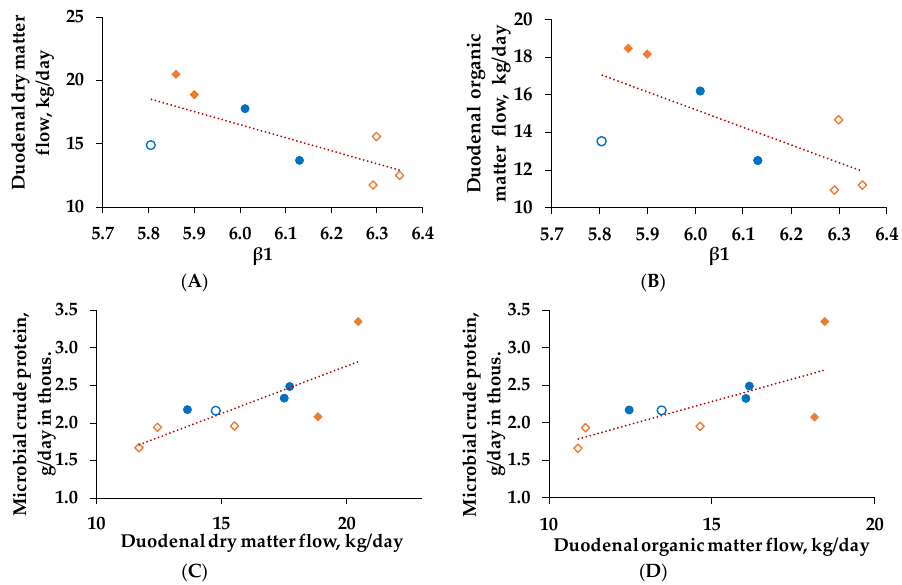
Figure 6. Regression of β 1 (describing the inflection point of the curve and representing the average pH of the 24 h period) on duodenal dry matter flow (DMF, A , y = -10.25x + 77.97, r 2 = 0.598, p < 0.05) and of β 1 on duodenal organic matter flow (OMF, B , y = -9.42x + 71.74, r 2 = 0.594, p < 0.05), as well as of DMF microbial crude protein ( C , y = 0.13x + 0.23, r 2 = 0.646, p < 0.05) and of OMF on microbial crude protein ( D , y = 0.12x + 0.47, r 2 = 0.536, p = 0.061) for the duodenal fistulated cows (n = 9) for the week of duodenal chyme sampling (in average week 13 postpartum ± 16 days). After calving cows were assigned to a group with 60% concentrate feed proportion (increasing from 35-60% during the first three weeks after parturition, C 60 , orange , n = 5) and a group with 35% concentrate feed proportion ( C 35 , blue , n = 4) in the ration. For the week of duodenal chyme sampling cows were additionally grouped into a more (206 ± 17 g/kg, / , n = 5) and a less efficient (122 ± 17 g/kg, ○ / ◊ , n = 4) group in compliance with the average microbial efficiency of 156 g/kg, defined as synthesized microbial crude protein/fermented organic matter according to GfE [15]. Correlation of ( A ) and ( B ) was conducted with eight animals, due to a missing β 1 value for one more efficient cow of C 35 .